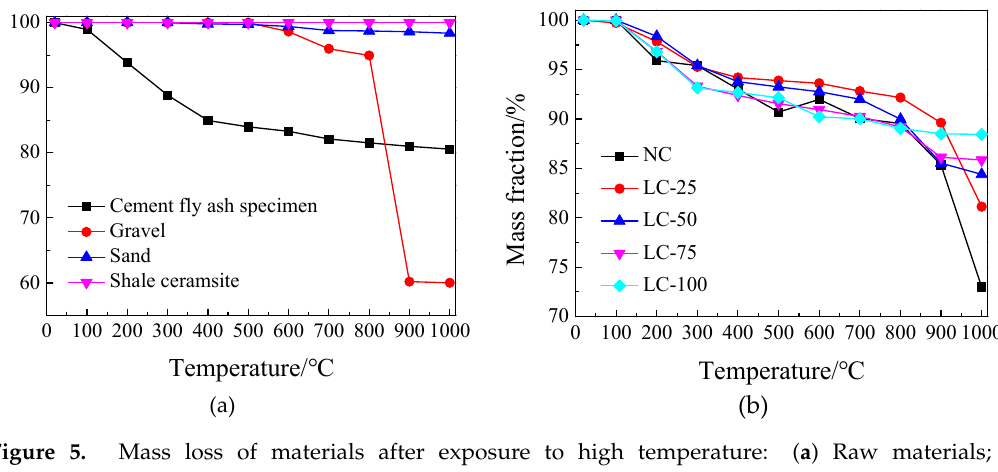
Figure 5. Mass loss of materials after exposure to high temperature: ( a ) Raw materials; ( b ) Concrete specimens.